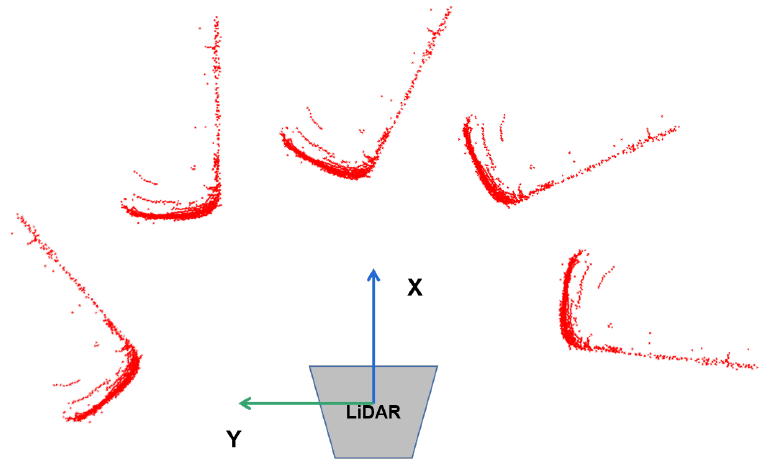
Figure 3. Point cloud distribution with the same observation angle. The local point cloud distribution is the same, but the rotation angle is